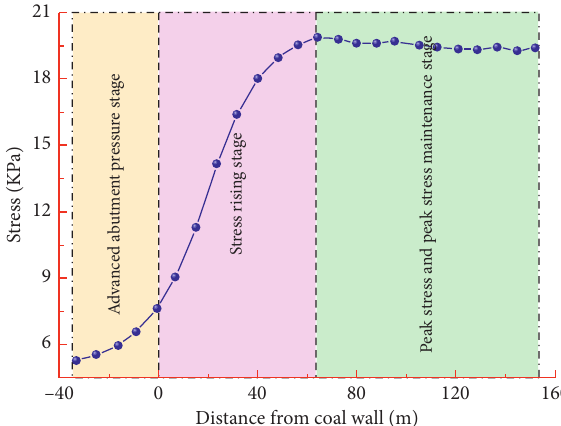
Figure 11: Lateral abutment pressure evolution curve.